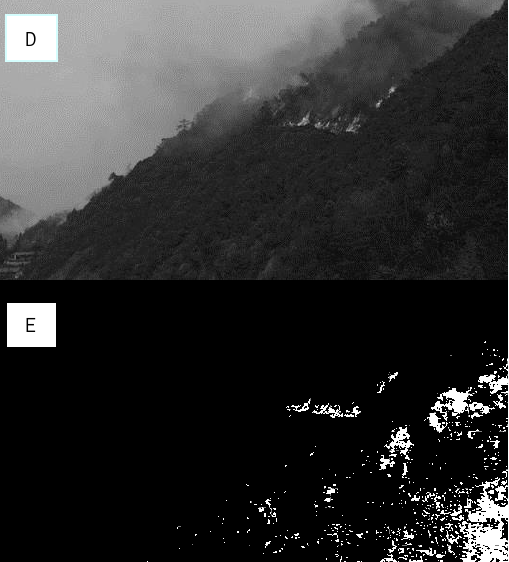
Figure 2. Color Space Conversion Based on HSI Color Model